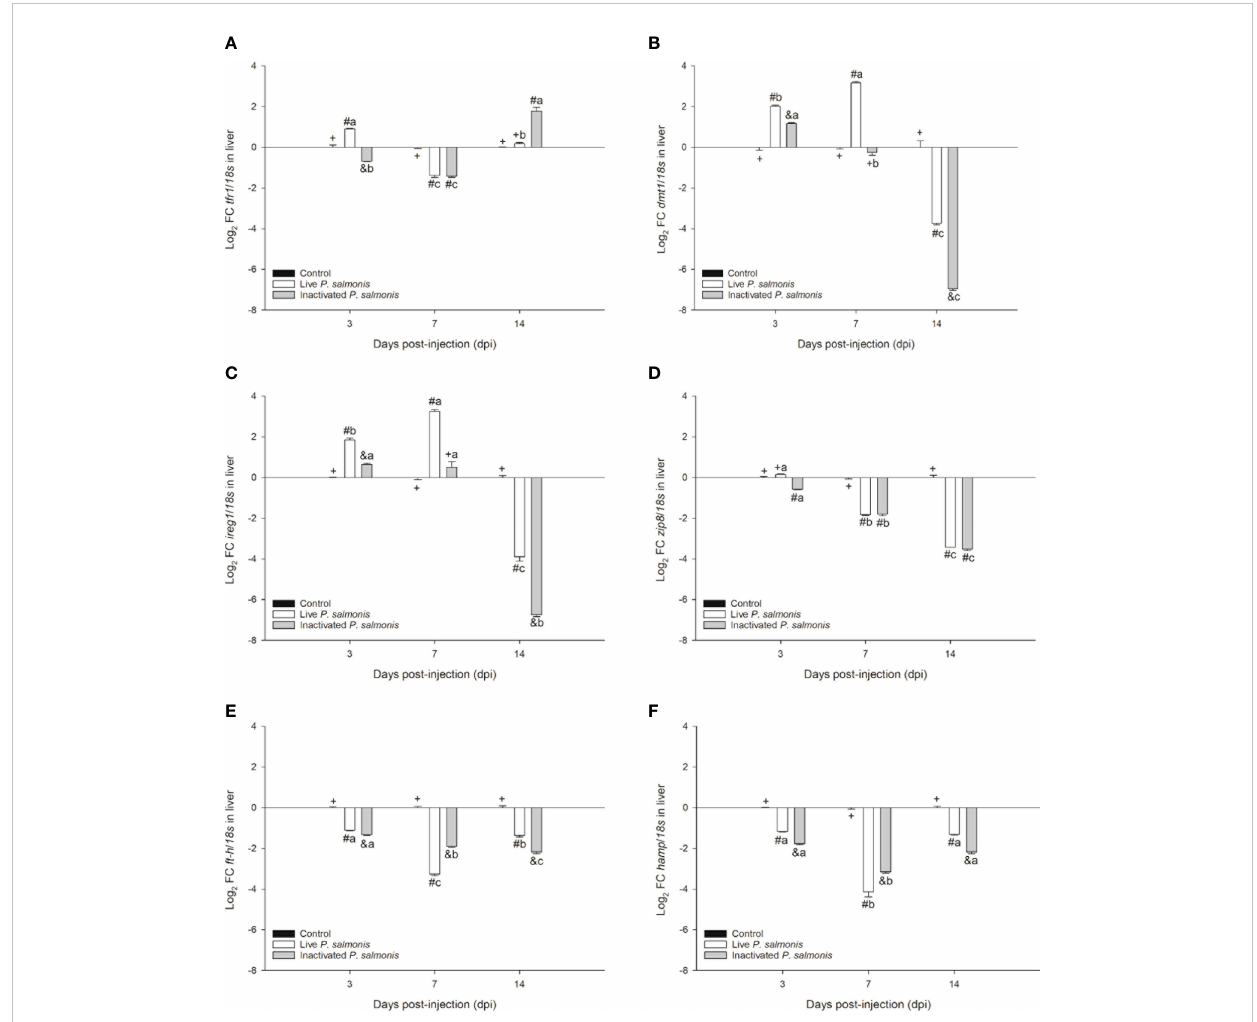
FIGURE 4 Gene expression of markers involved in nutritional immunology in S. salar . The samples were taken at 3, 7, and 14 days after injection (dpi). (A) : transferrin receptor 1. (B) : divalent metal transporter 1. (C) : ferroportin 1. (D) : zinc transporter 8. (E) : ferritin heavy chain. (F) : hepcidin. Symbols (+, #, &) over the bars indicate statistical differences between the different treatments at the same time points. Different letters a, b, c indicate statistical differences in the same treatment at different times. Two-way ANOVA, p < 0.05;